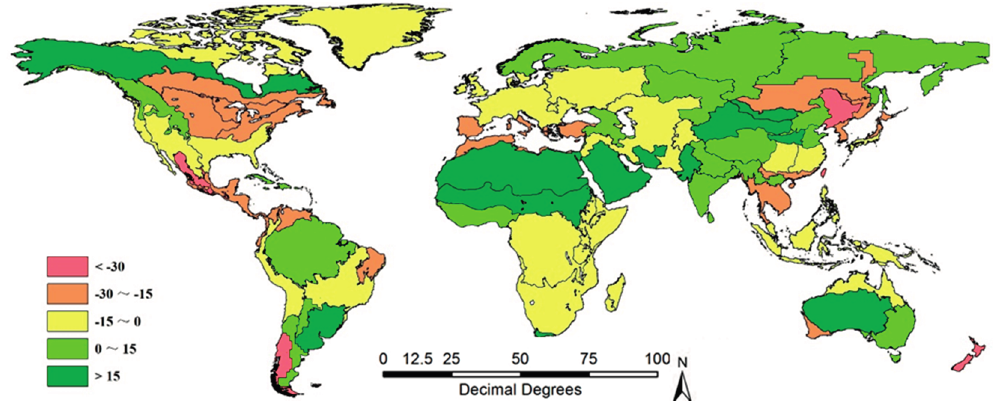
Figure 8. January to April 2014 global map of potential biomass departure from the 2001–2013 average, over sixty-five crop Mapping and Reporting Units; the difference is expressed as percentage of the reference (%).